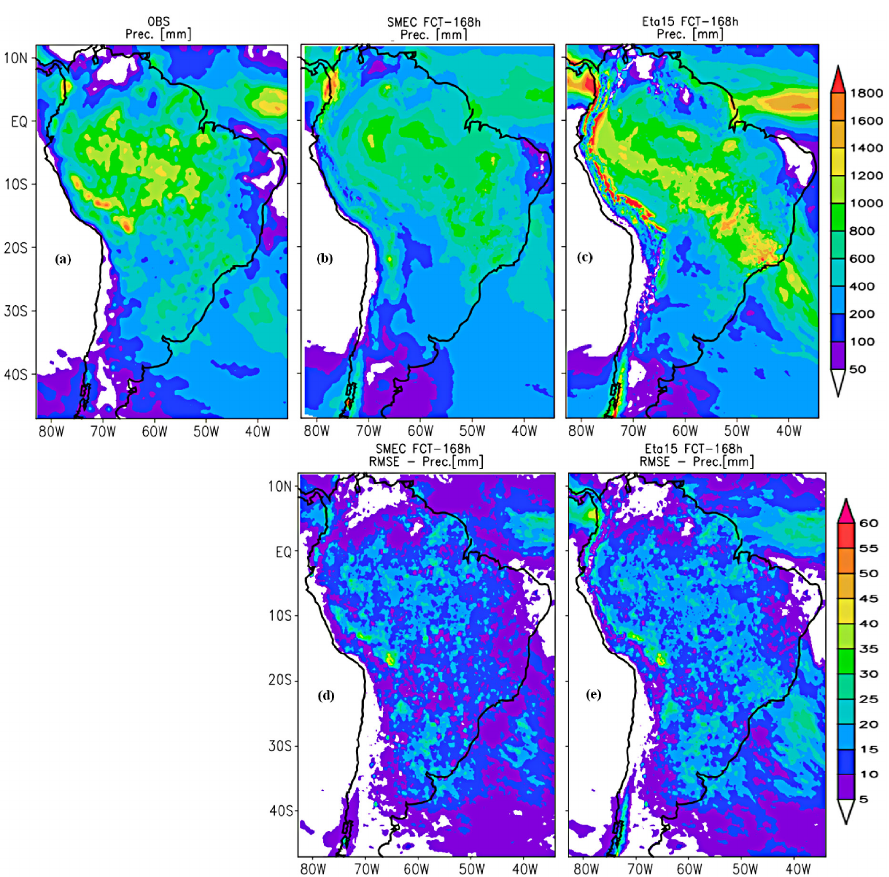
Figure 6. Precipitation accumulated during the summer period for MERGE (a) , forecasts of 168h from SMEC (b) and Eta15 (c) , and their respective RMSE (d, e) .